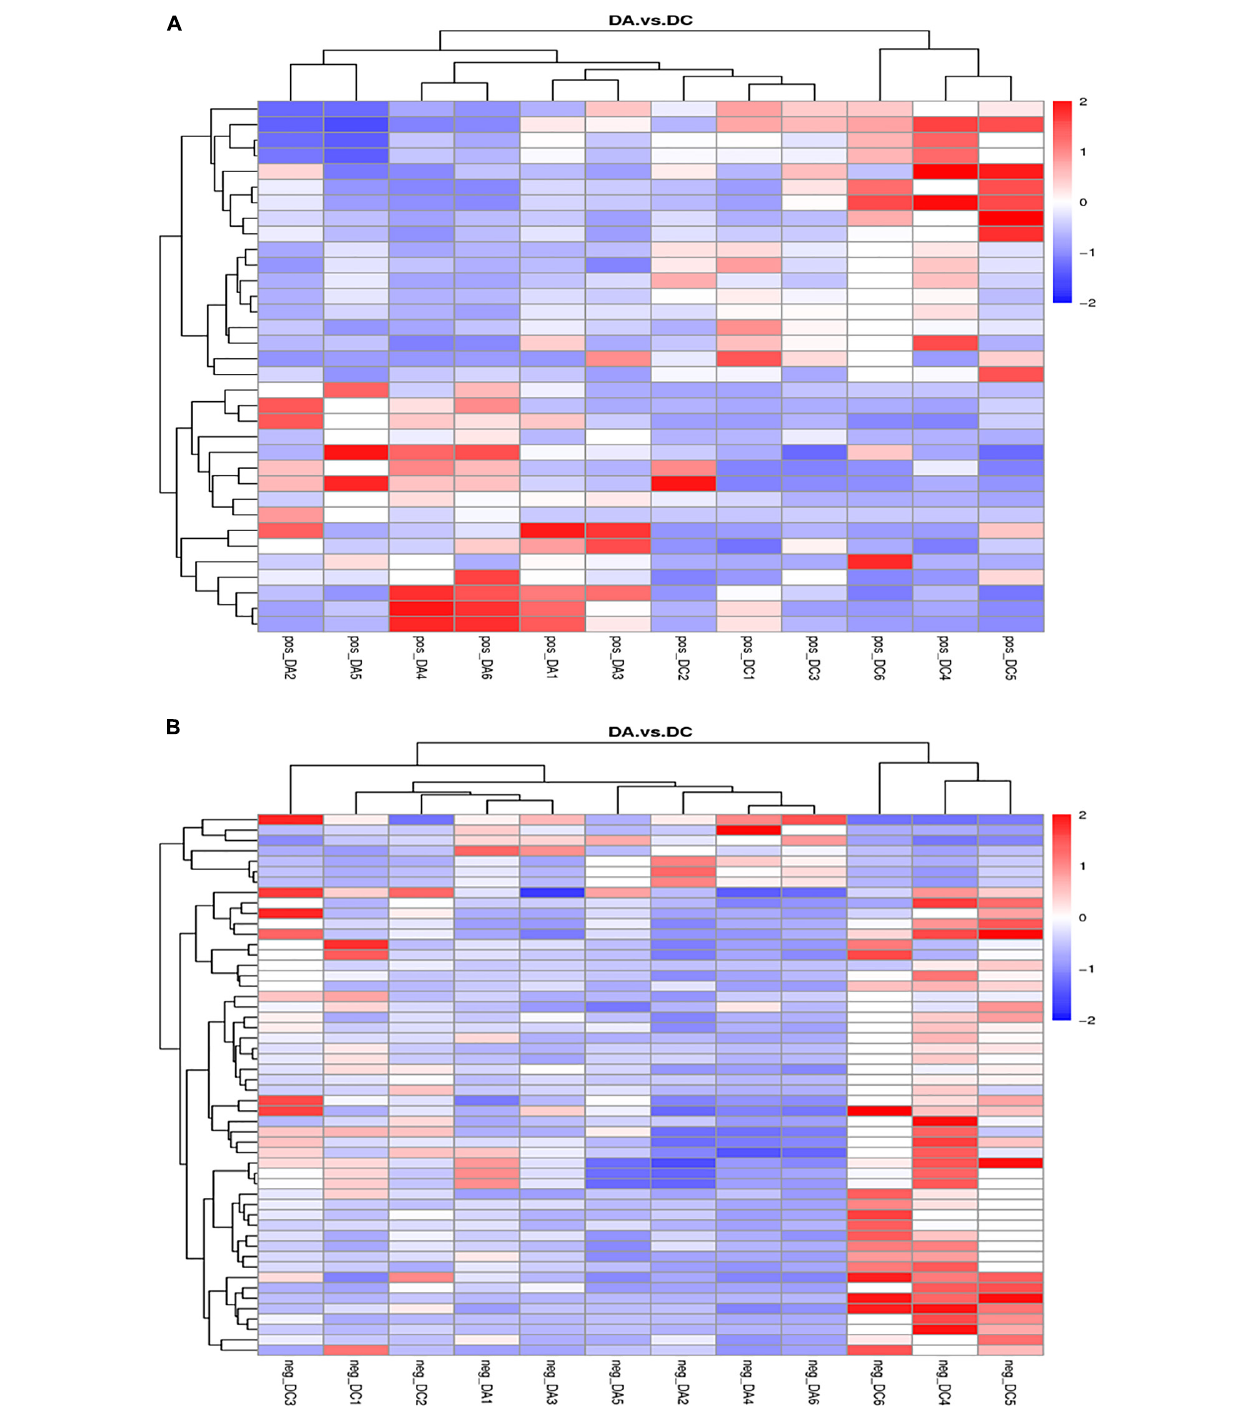
FIGURE 9 | Clustering diagram of differential metabolites. (A) Positive ion mode and (B) negative ion mode.